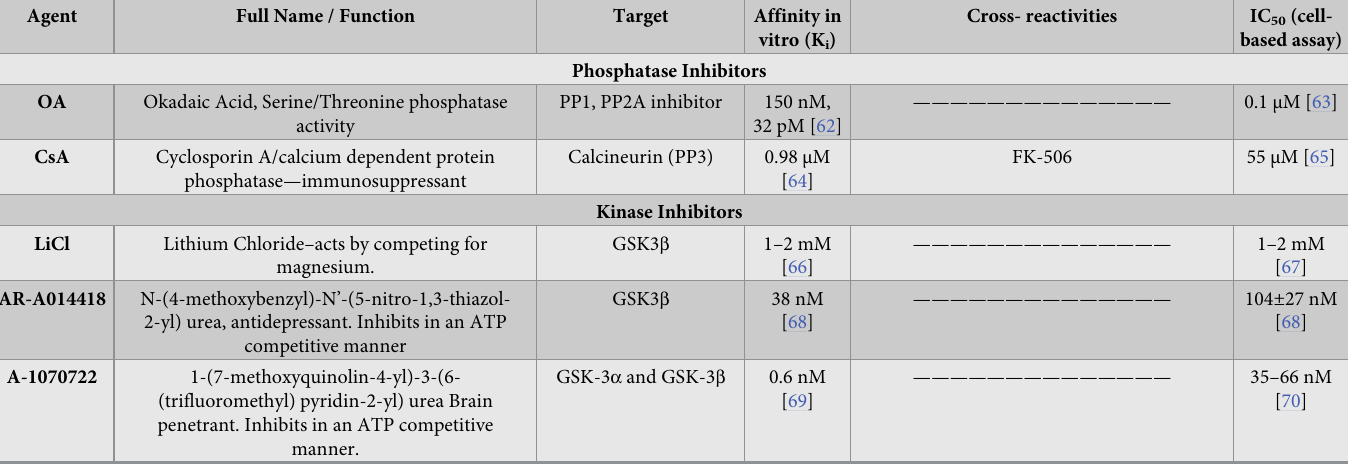
Table 1. Phosphatase, kinase inhibitor and other pharmacological agents used in the